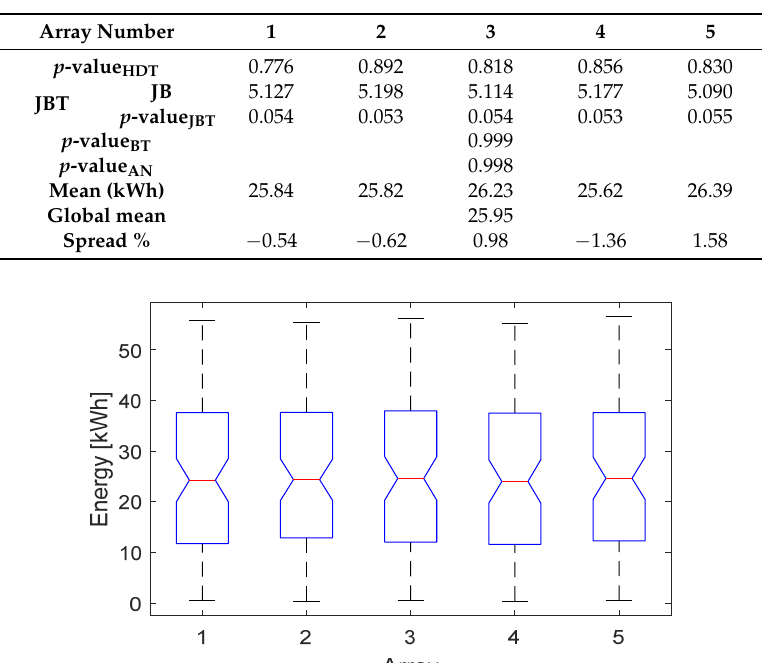
Table 3. p -Value of HDT, JBT, BT, ANOVA for the energy distribution of the arrays, and mean in kWh and spread with respect to the global mean for three-month analysis (January–March).